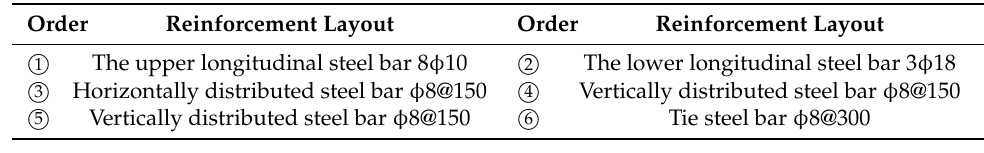
Table 7. The reinforcement layout of the deep T-beam specimens.